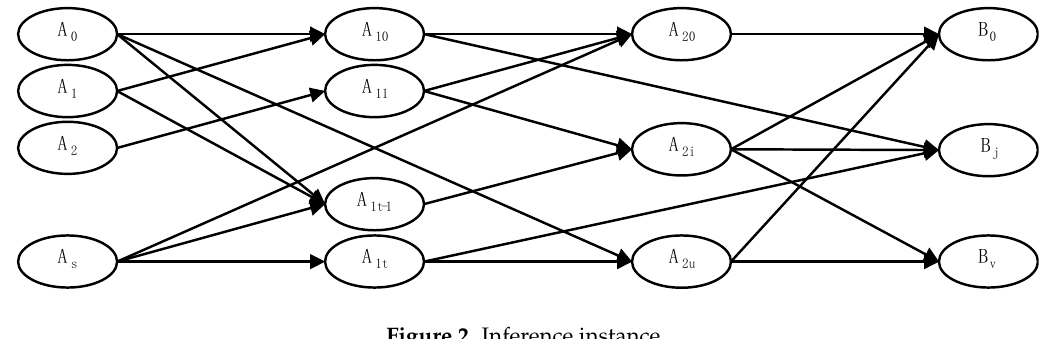
Figure 2. Inference instance.